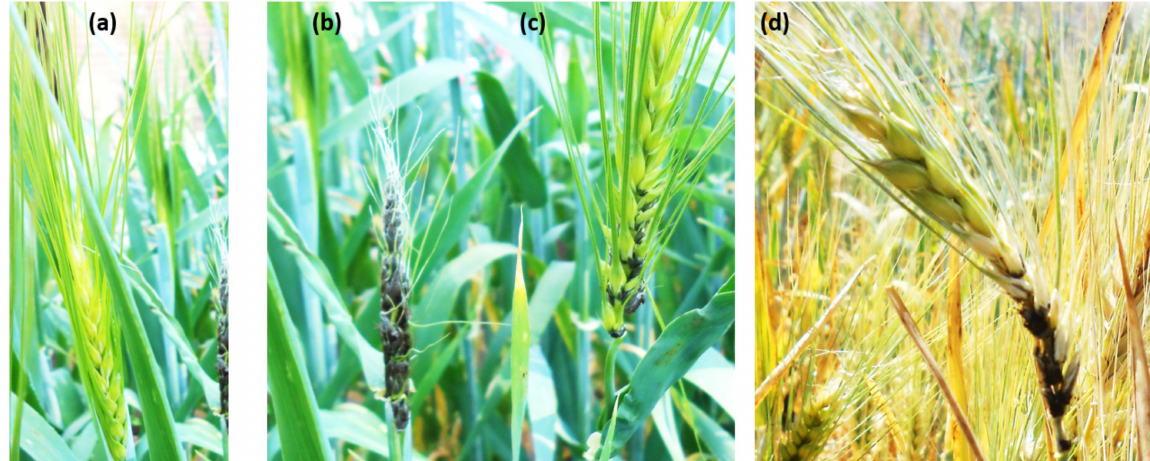
Figure 2. The effect of the Egyptian loose smut race on barley spikes ( a ) health spikes ( b ) susceptible spikes, ( c , d ) different degrees from few partially infected spikes found in some resistant